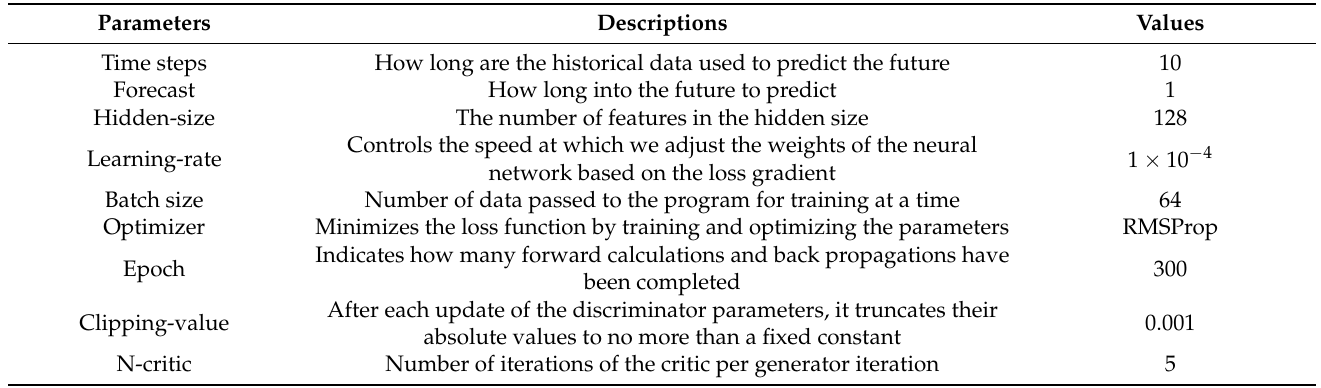
Table 4. Required parameters in